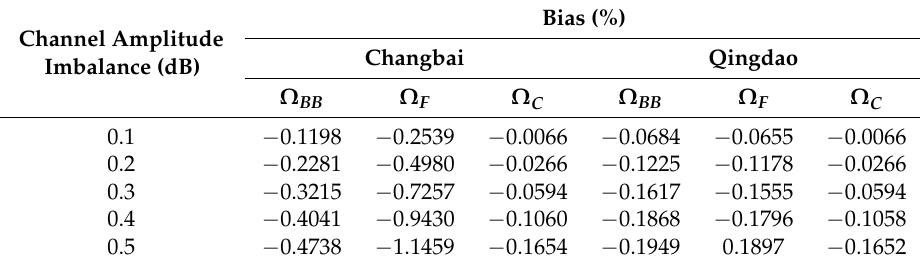
Table 8. Bias ( σ bias ) under the condition of channel amplitude imbalance.